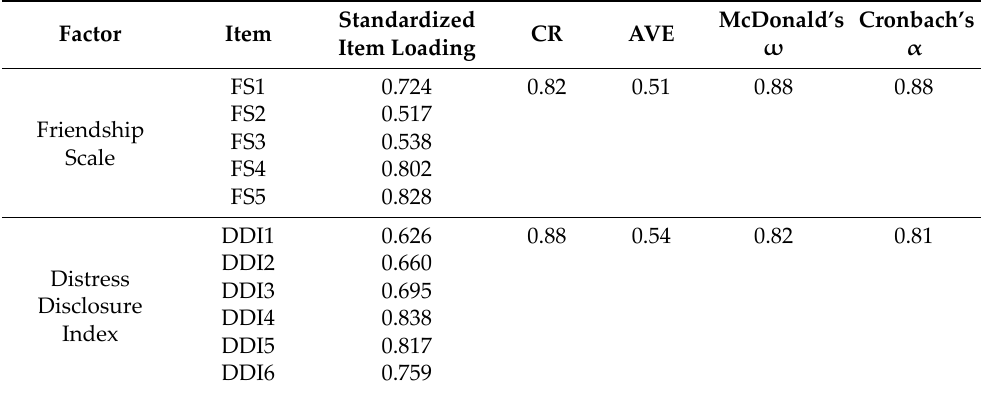
Table 3. Standardized item loadings, CR, AVE, McDonald’s ω , and Cronbach’s α of measurement